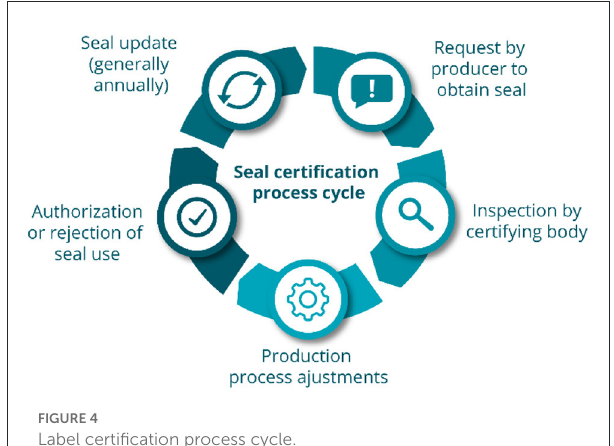
FIGURE4 Label certification process